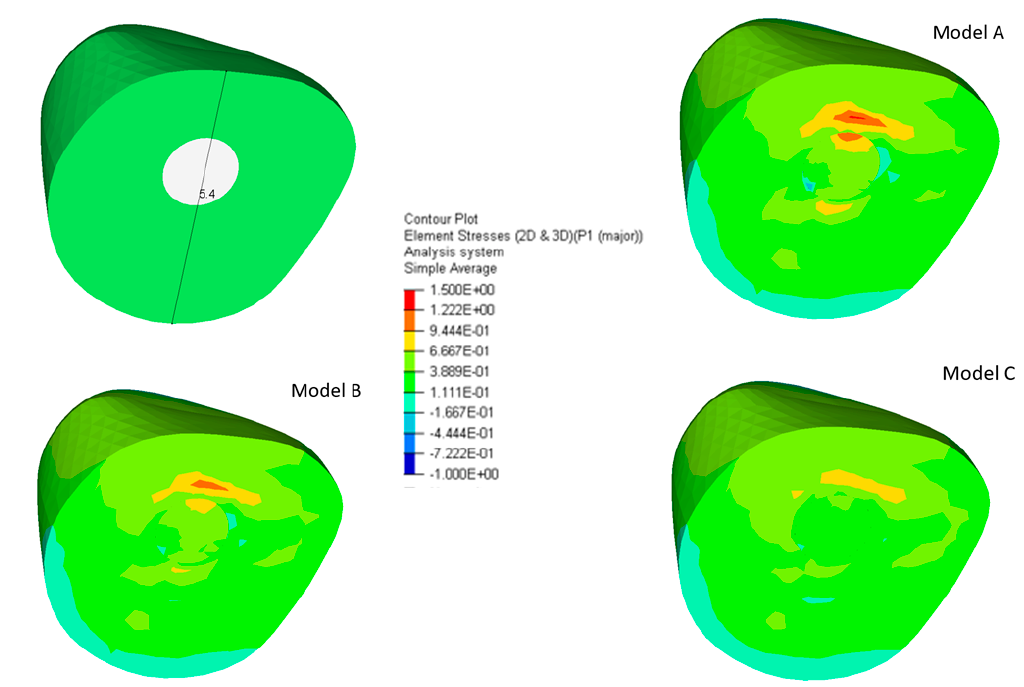
Figure 7. Cross sections at the cervical margin of the tooth (upper left) and maximum principal stress distributions for the three models.